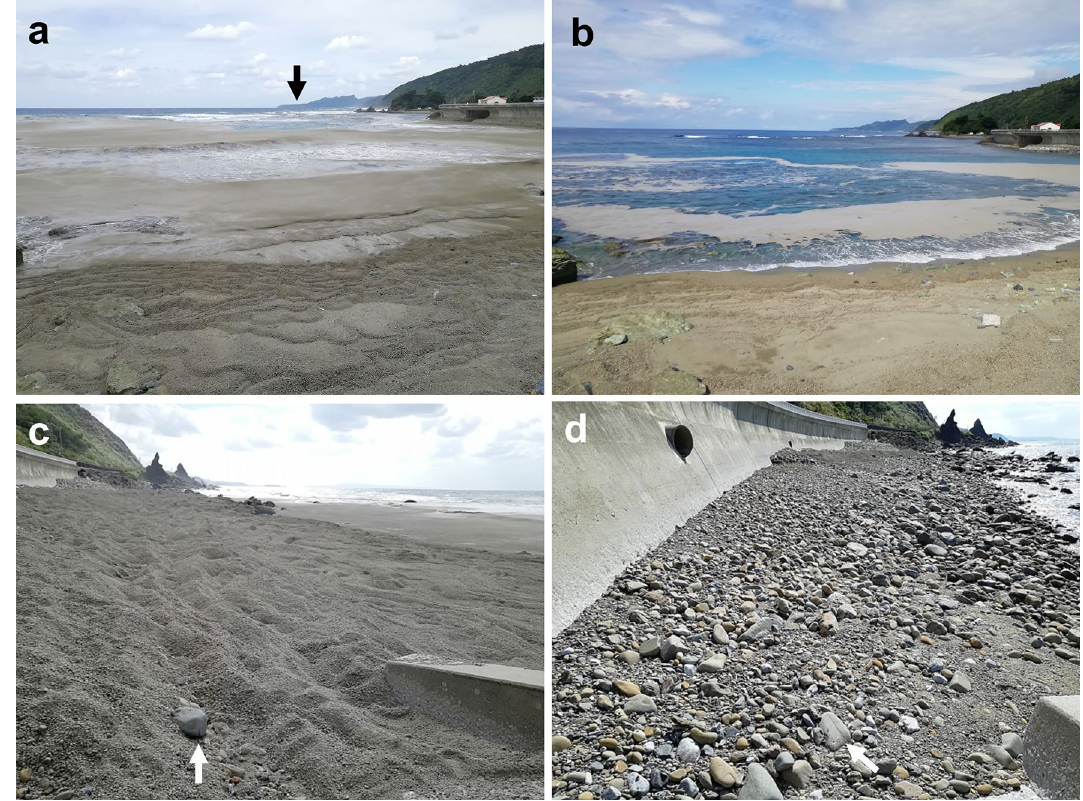
Figure 3. Short-term migration of pumice from beaches as revealed by stationary observations. These four photos were taken at two sites on northern Okinawa Island on two consecutive days, 23 and 24 October 2021. ( a , b ) A sandy beach along the Sate Coast (26°78 ′ 84.56 ″ N, 128°22 ′ 30.57 ″ E). It was windy on the first day, and pumice stones were washed up with the waves. Almost all the pumice stones were removed from the beach and transported offshore on the following day. The black arrow in photo (a) indicates Cape Hedo, the northernmost tip of Okinawa Island. ( c , d ) At this gravelly beach (26°80 ′ 83.25 ″ N, 128°23 ′ 38.56 ″ E), pumice fully covers the seawall on the first day, but all of the pumice stones washed away, leaving the original gravels, on the following day. The white arrow in each photo indicates an identical marker stone placed on the beach. Weather data of northern Okinawa (https:// www. data. jma. go. jp/ obd/ stats/ etrn/ view/ daily_ a1. php? prec_ no= 91& block_ no= 0901& year= 2021& month= 10& day= 23& view=g_ wsp) and tidal data (Naha: 26°13 ′ N, 127°40 ′ E) (https:// www. data. jma. go. jp/ gmd/ kaiyou/ db/ tide/ genbo/ genbo. php) are provided by Japan Meteorological